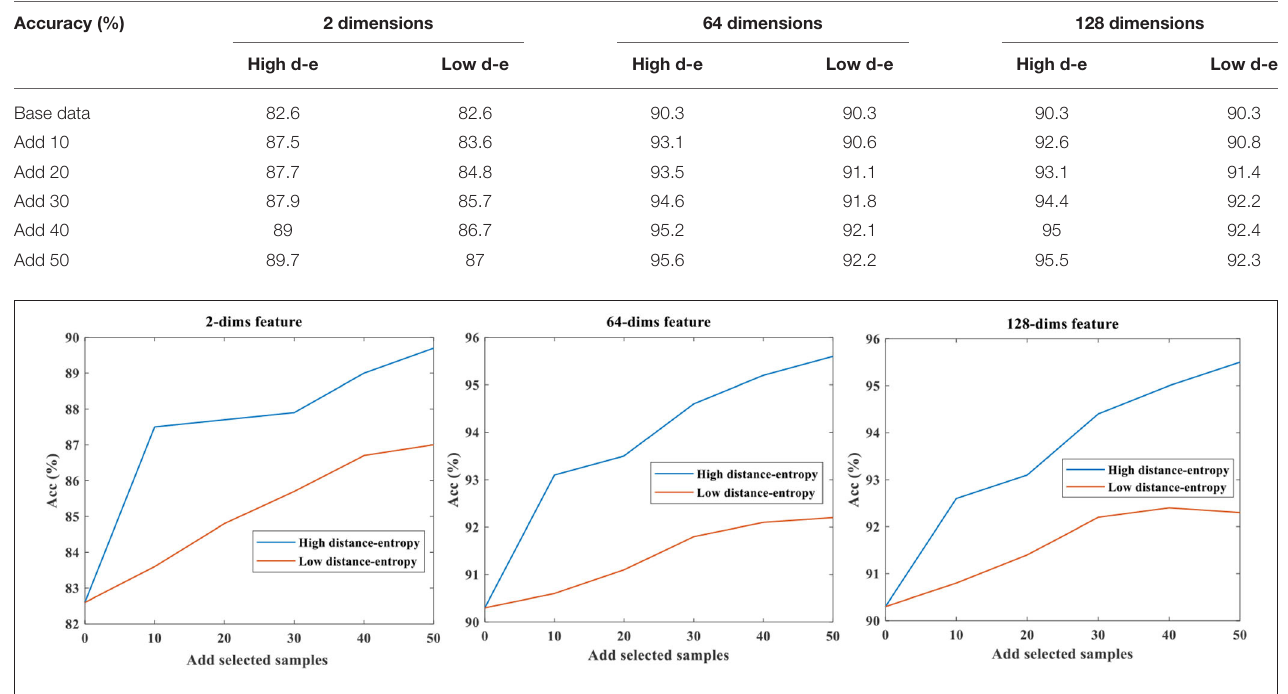
FIGURE 5 | The accuracy testing under different mapping feature dimensions.